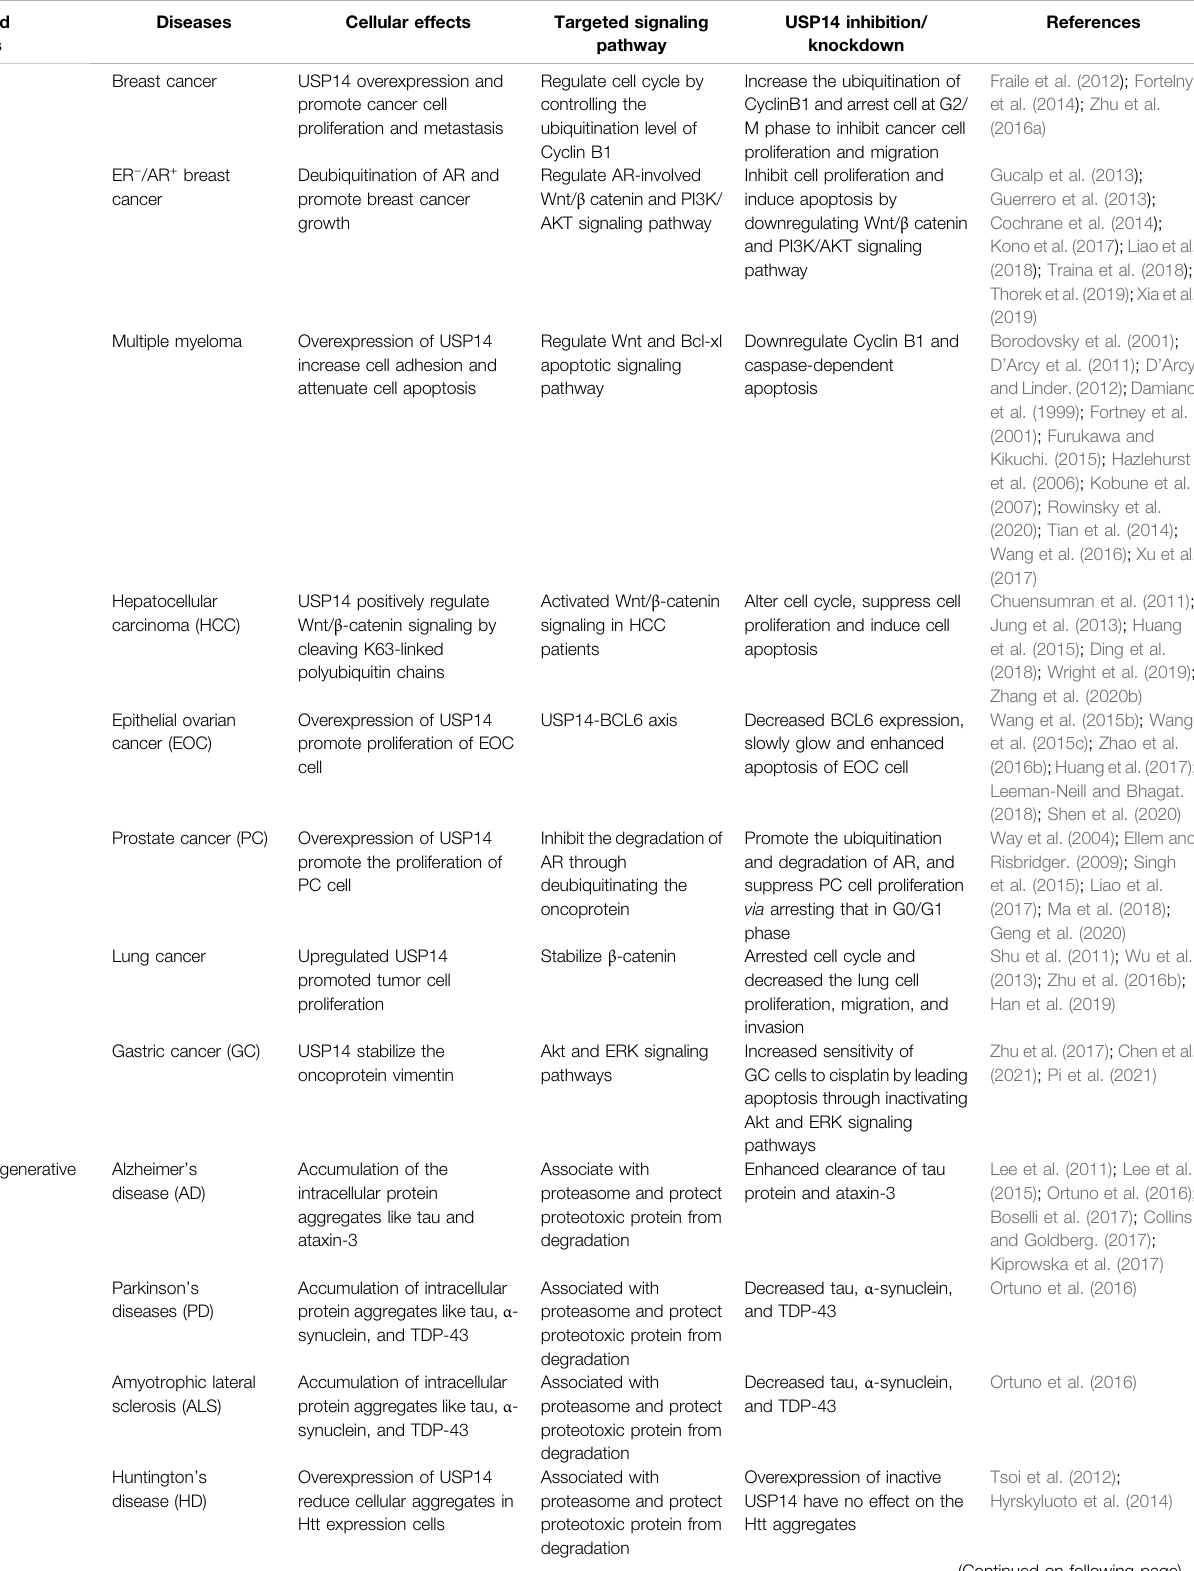
TABLE 2 | USP14 connected with various pathophysiological processes via different signaling